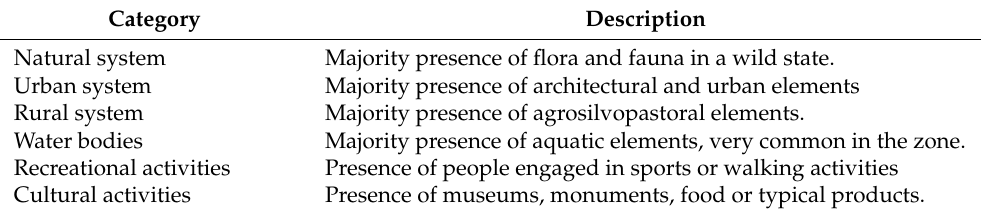
Figure 3. Diagram of photograph database processing and sampling. Table 1. Photographs categories.